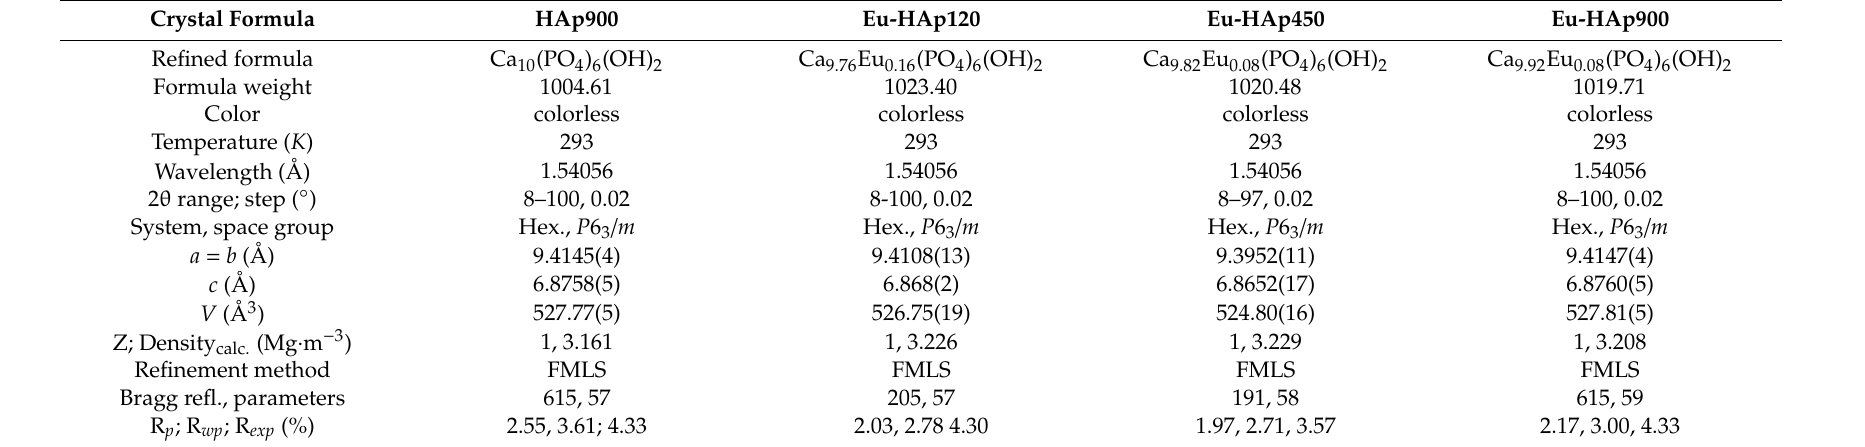
Table 2. Acquisition and structure refinement parameters for HAp samples. FMLS: